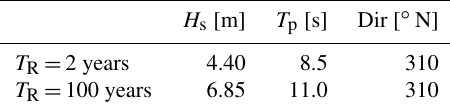
Table 1. Interpretation of extreme events using the hindcasted northern wave data at the selected location off the Bay of Vlorë.